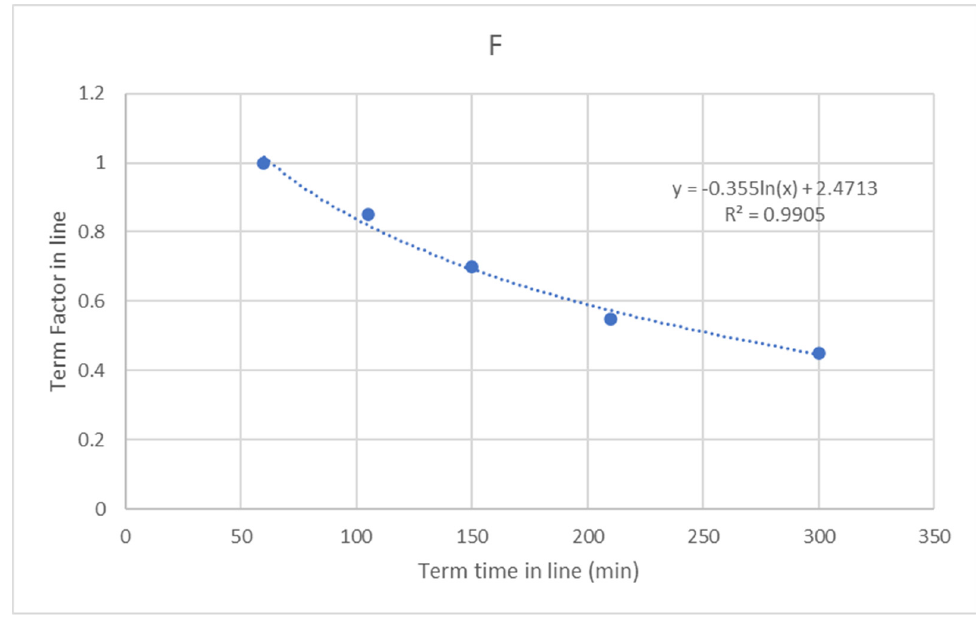
Figure 8. Evolution of the dwell time factor.